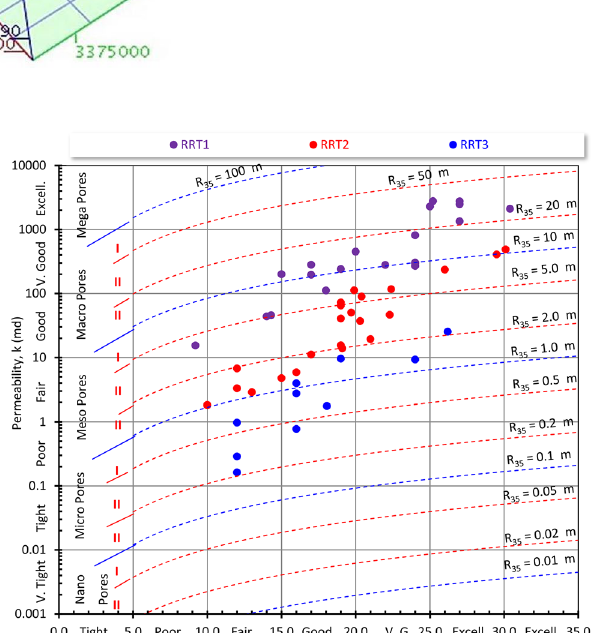
Fig. 16 Effective pore throat sizes estimated as R Albian reservoir rock types in the M and L1